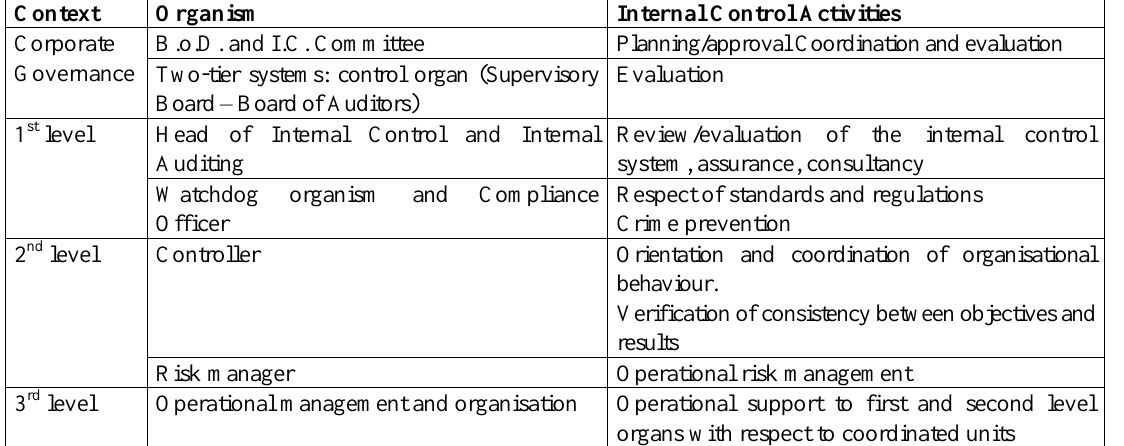
Table 1: The Corporate Internal Control